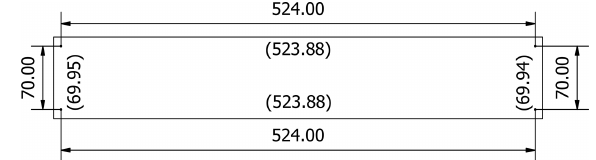
Figure 6. Comparison of measured and design values for coil ref- erence points. Measured values are in parentheses (in millimeters).